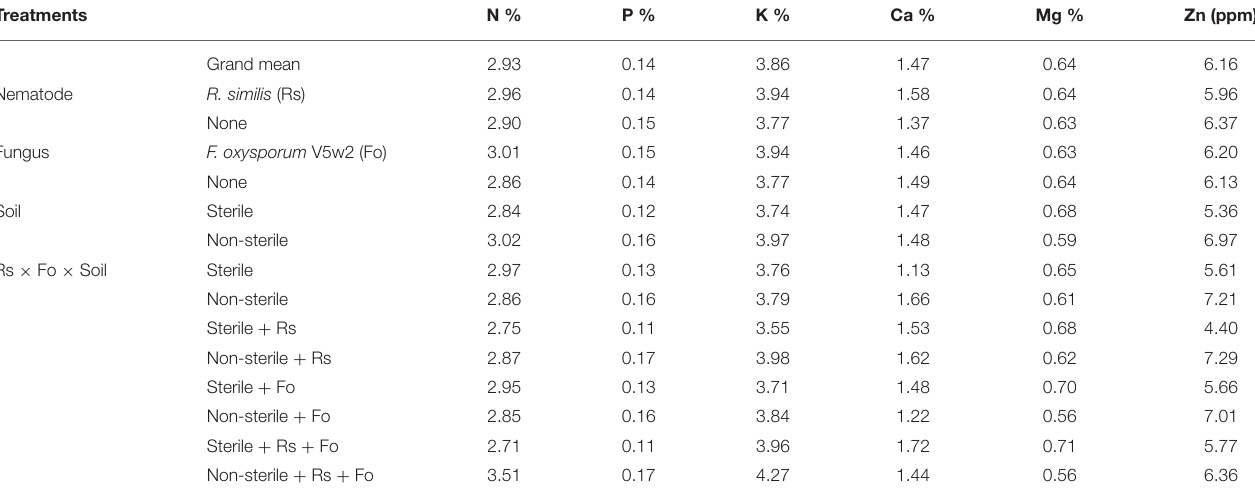
TABLE 2 | Nutrient content in banana leave tissues from plants under independent and combined inoculation with Radopholus similis and Fusarium oxysporum V5w2 having grown in sterile or non-sterile soil and supplied with complete nutrient solution. Treatments N % P % K % Ca % Mg % Zn (ppm) Grand mean Nematode